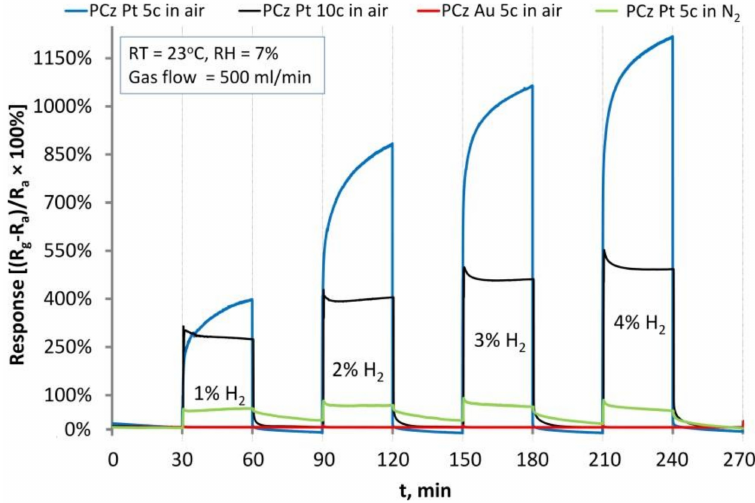
Figure 2. Response of representative (average performance) PCz/IDE-Au and PCz/IDE-Pt sensors to H 2